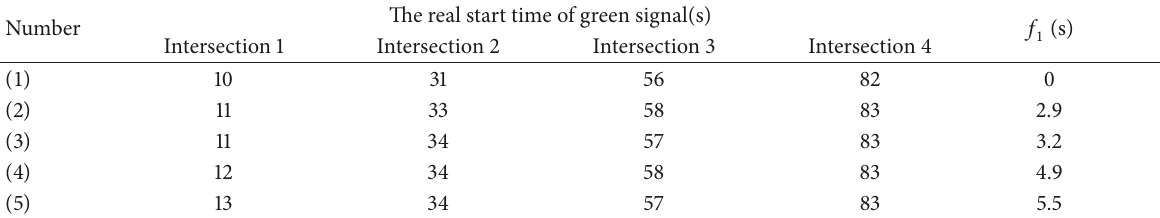
Table 2: The Pareto solution set of EV when 𝑡 0 is 10 o’clock.